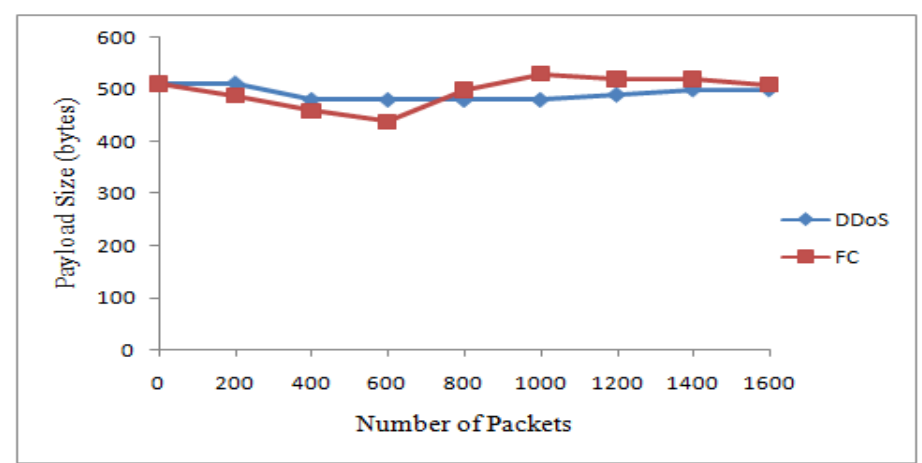
Figure 8. Discrimination based on the size of payload.